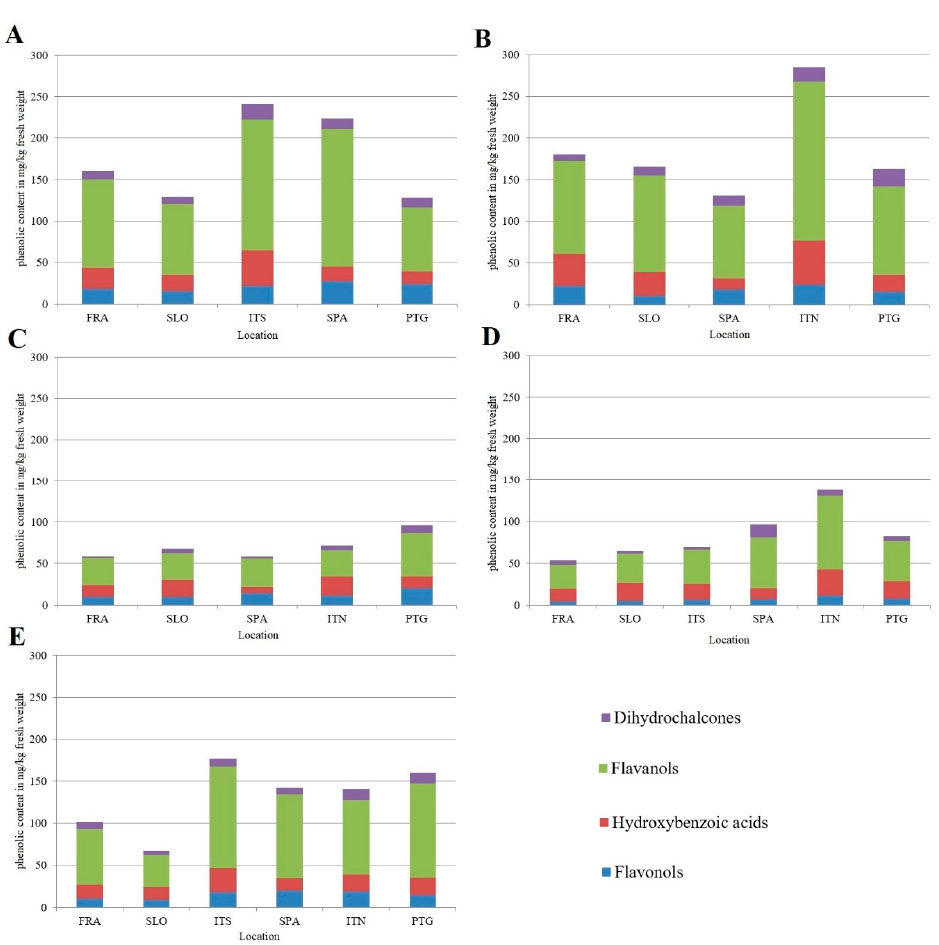
Figure 1. A comparison of the contents of different phenolic groups in the kernels of five different cultivars, ( A ) ‘Barcelona’, ( B ) ‘Pauetet’, ( C ) ‘Merveille de Bollwiller’, ( D ) ‘Tonda di Giffoni’, and ( E ) ‘Tonda gentile delle Langhe’, grown in six different regions of Europe. FRA, France; ITS, central Italy; ITN, north Italy, SLO, Slovenia; SPA, Spain; PTG, Portugal